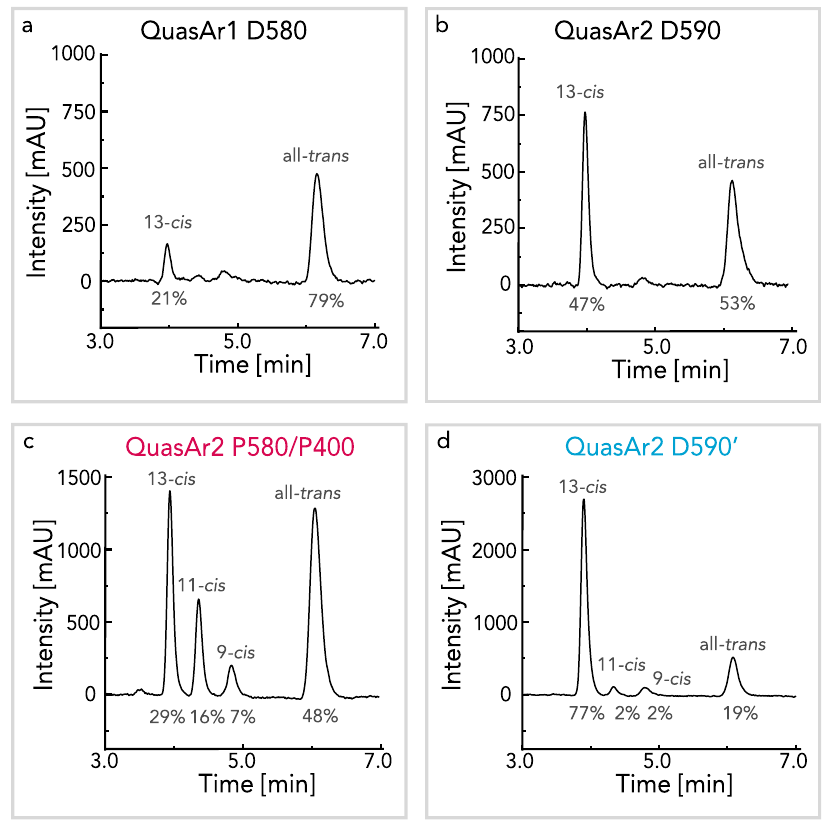
Fig. 2 | Retinal extract HPLC chromatogram. HPLC of extracted retinal isomers isolated from IDS of QuasAr1 ( a ) and QuasAr2 ( b ). For QuasAr2, the photoproduct chromatograms are shown for P580/P400 ( c ) and D590 ’ ( d ). The sample was illu- minated for30s with 625nm LED ( c ) and additional30s illuminationwith 400nm